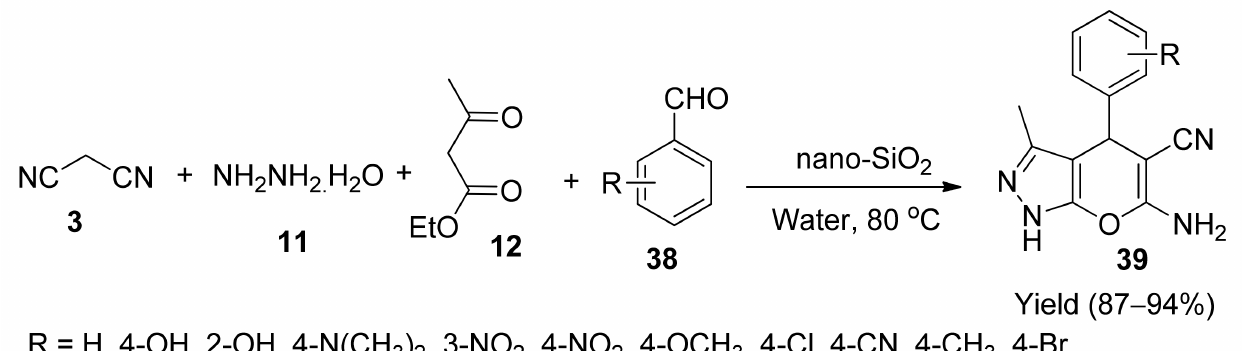
Scheme 10. Synthesis of pyranopyrazole derivatives 39 using SiO 2 .